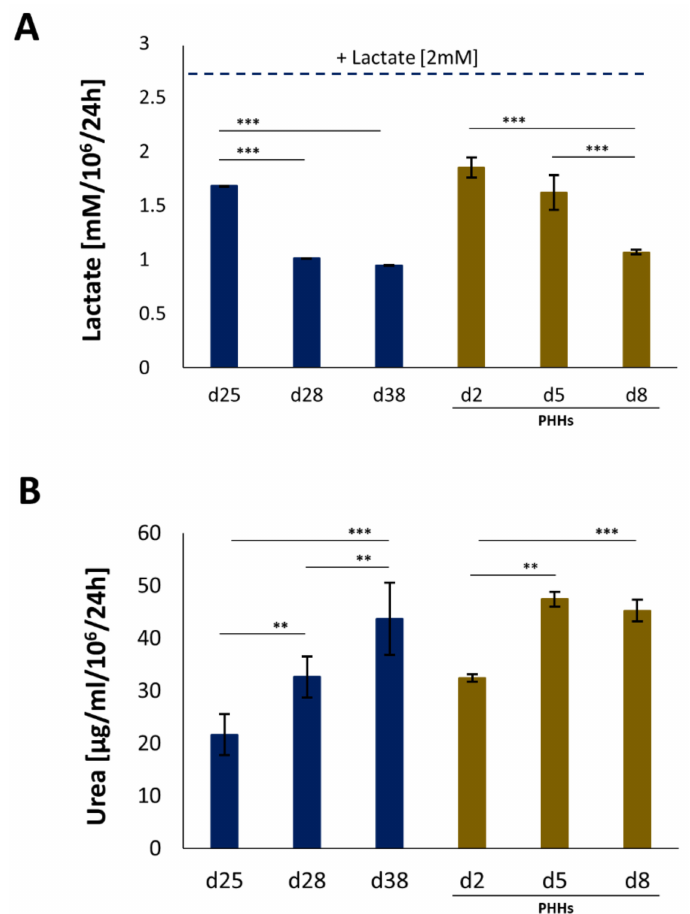
Figure 6. Detoxification abilities of iHep-Orgs in moderate pathological conditions. ( A ) Lactate detoxification and ( B ) urea synthesis of iHep-Orgs (blue bars) and PHH-Orgs (brown bars). Graphs represent mean ± SD ( n = 8). *** indicate p < 0.001; ** indicate p <